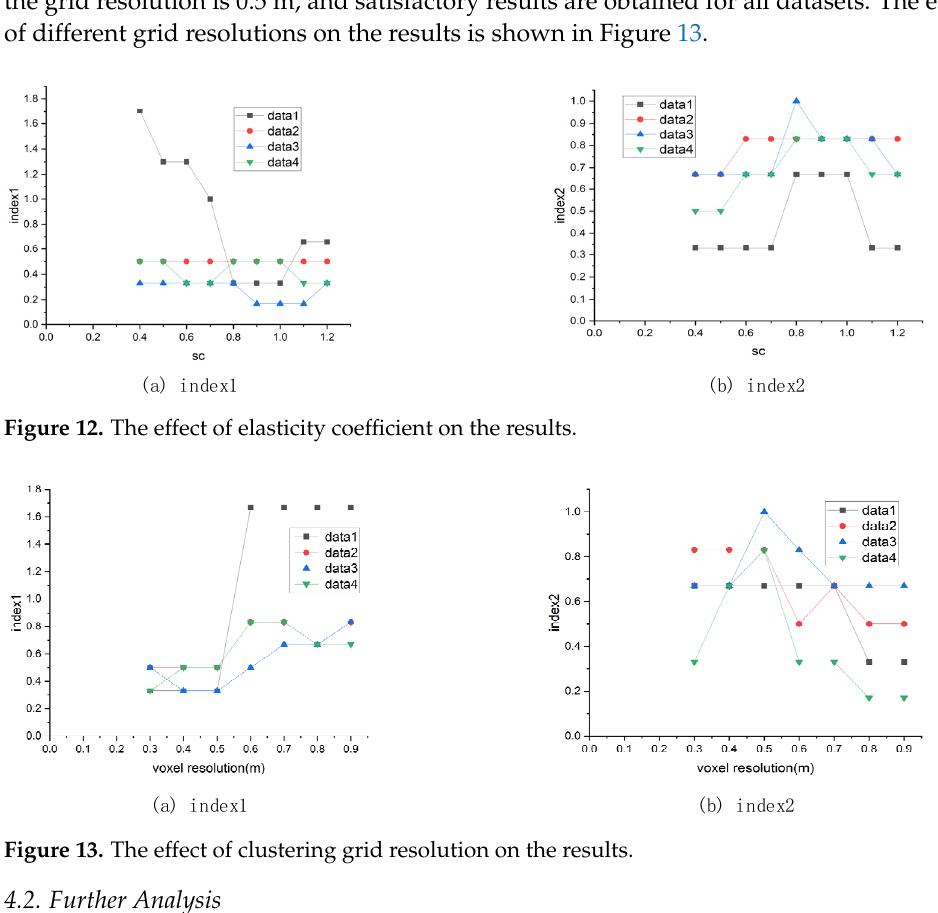
(b) index2 Figure 11. The effect of the height difference threshold on the results. The elastic coefficient between the cloth particles affects the internal spring force con-